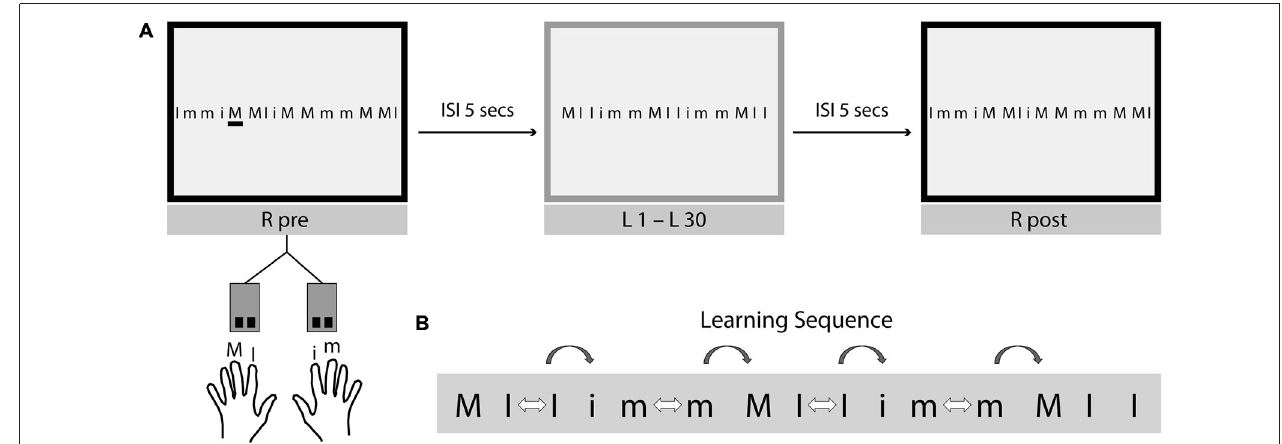
FIGURE 1 | Experimental setup and design. (A) Bimanual Serial Reaction Time Task (B-SRTT). The task was to perform the B-SRTT on two training days (TD1 and TD2), which were separated by at least 1 week. Participants were presented with a learning sequence consisting of a 15-letter array on a computer screen, with the letters m and i. Capital letters (I, M) correspond to button presses of left index (I)- and middle finger (M) respectively and small typed letters (i, m) correspond to button presses of the right hand index (i)- and middle finger (m). The whole sequence was visible at once and the task was self-paced (=explicit motor learning task). Participants were asked to press the corresponding keys on a keyboard as fast and as accurate as possible. No time-limit was given during sequence presentation. The experiment started with the presentation of a random sequence (R pre), afterwards 30 repetitions of the learning sequence (L1–L30) were presented, followed by another presentation of the random sequence (R post). To avoid muscle fatigue, the interstimulus interval (ISI) between sequence presentations was 5 s. Each trial was followed by visual feedback regarding response times and the number of errors that participants made during the previous trial. (B) To investigate the effects of switching between-hands compared to switches within-hands (hand switch costs), there were 10 within-hand switches (white arrows) and 4 between-hand switches (grey arrows) implemented in the learning sequence. In order to keep a constant number of switches, only within-hand switches immediately before a between-hand switch were used for the analysis of hand switch